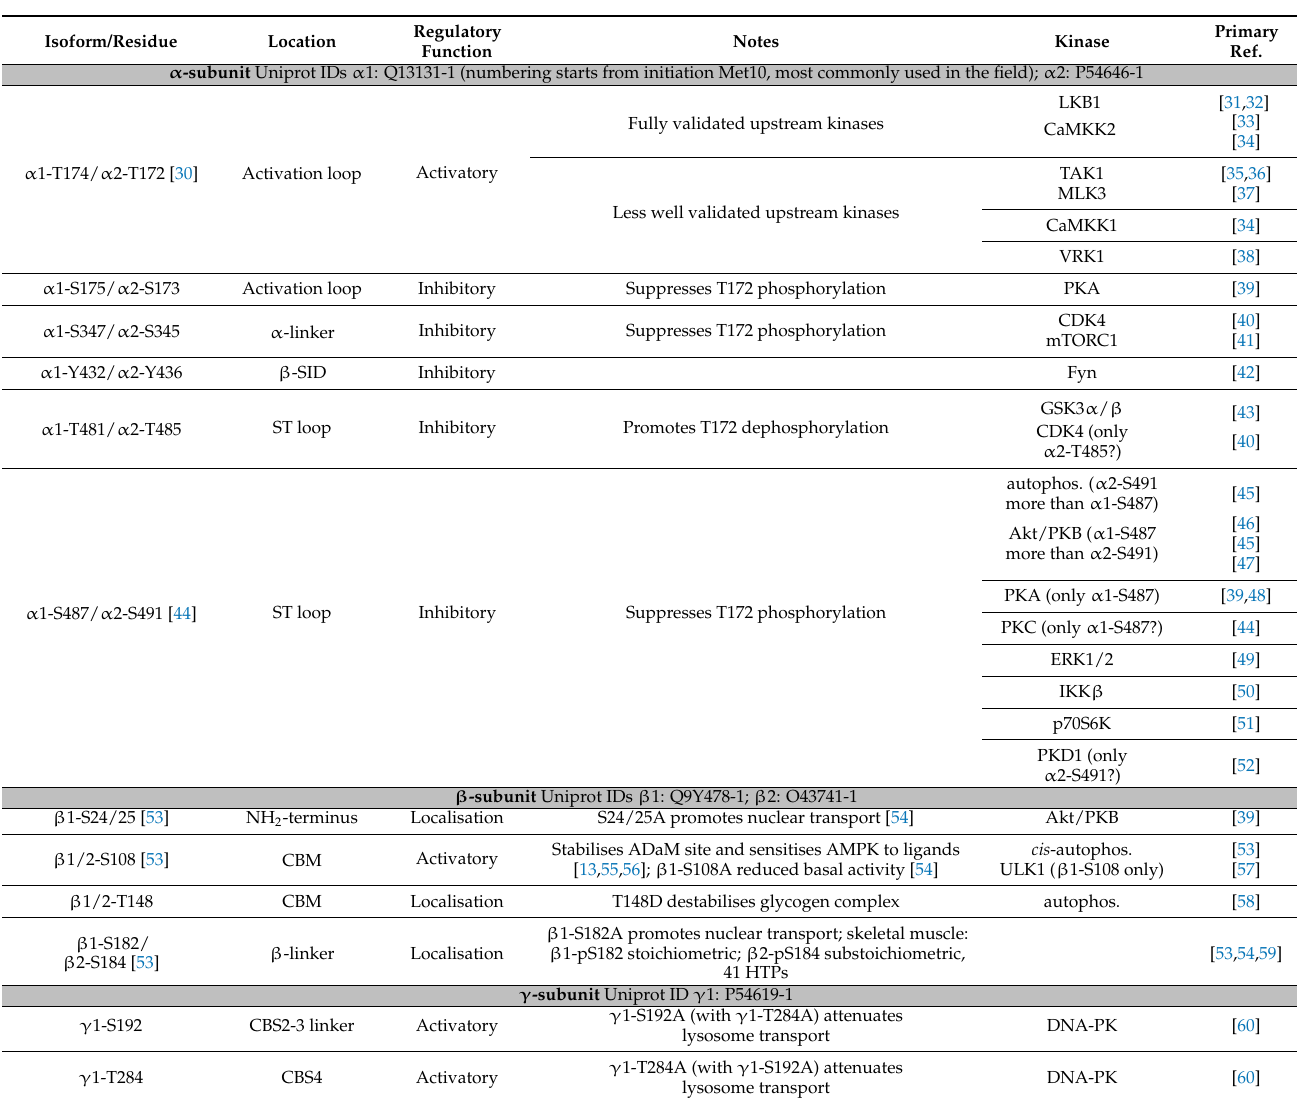
Table 1. AMPK phosphosites: regulatory function